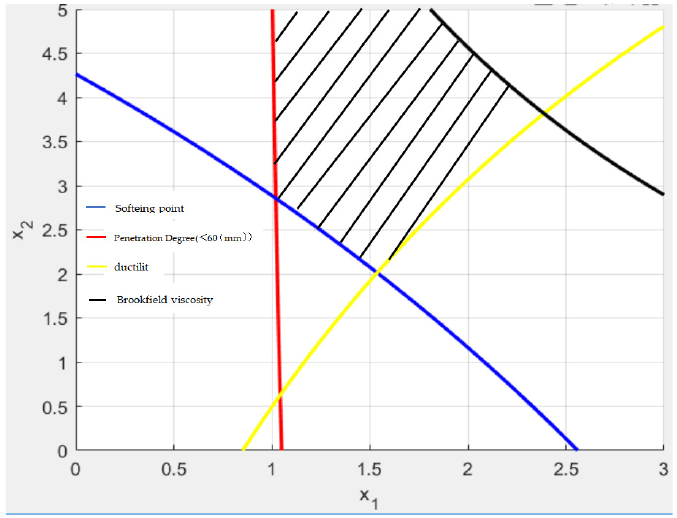
Figure 7. The best composite dosage of modifier in the disaggregation region.